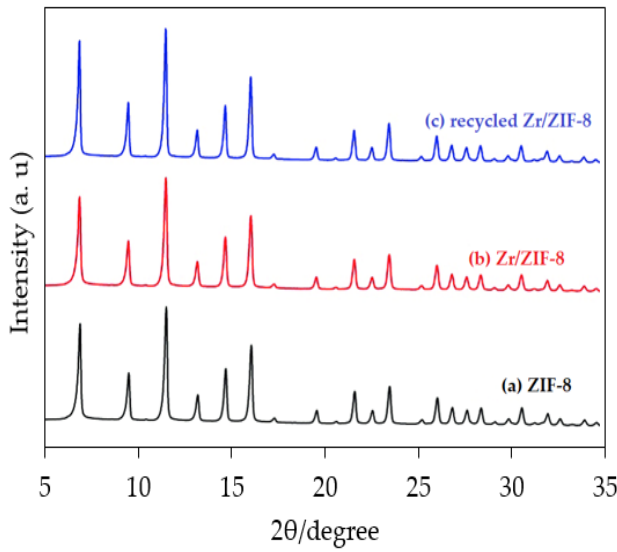
Figure 4. X-ray di ff raction (XRD) patterns of ( a ) ZIF-8, ( b ) Zr / ZIF-8, and ( c ) recycled Zr / ZIF-8 Figure 4. X-ray diffraction (XRD) patterns of ( a ) ZIF-8, ( b ) Zr/ZIF-8, and ( c ) recycled Zr/ZIF- 8 catalysts.